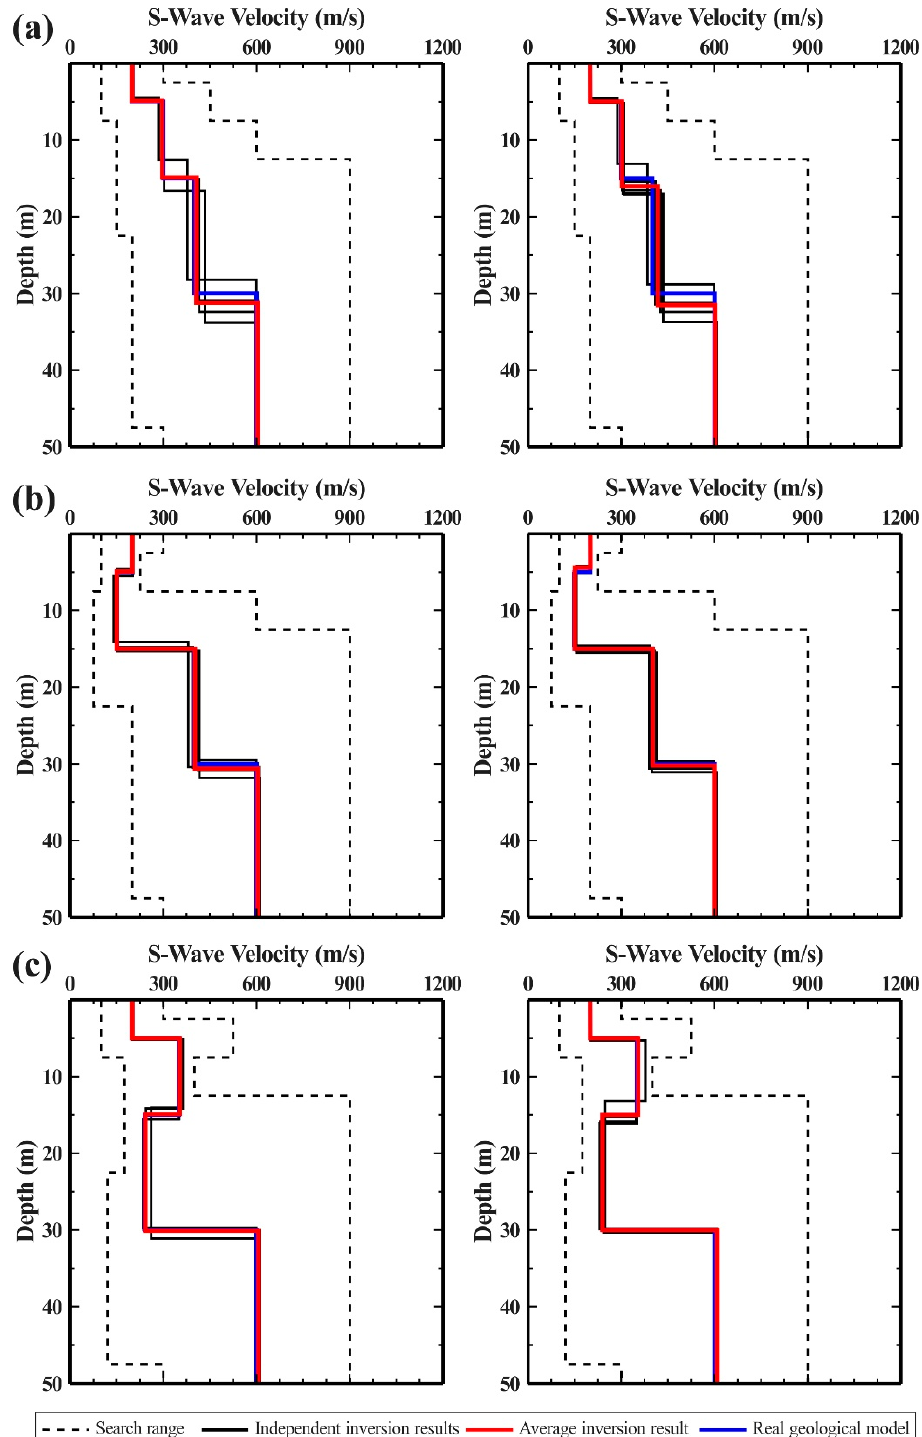
Figure 6. Inversion results of multi-order dispersion curves. The left and right figures correspond to the traditional and newly proposed inversion objective functions, respectively. ( a ) Model 1; ( b ) Model 2; ( c ) Model 3.